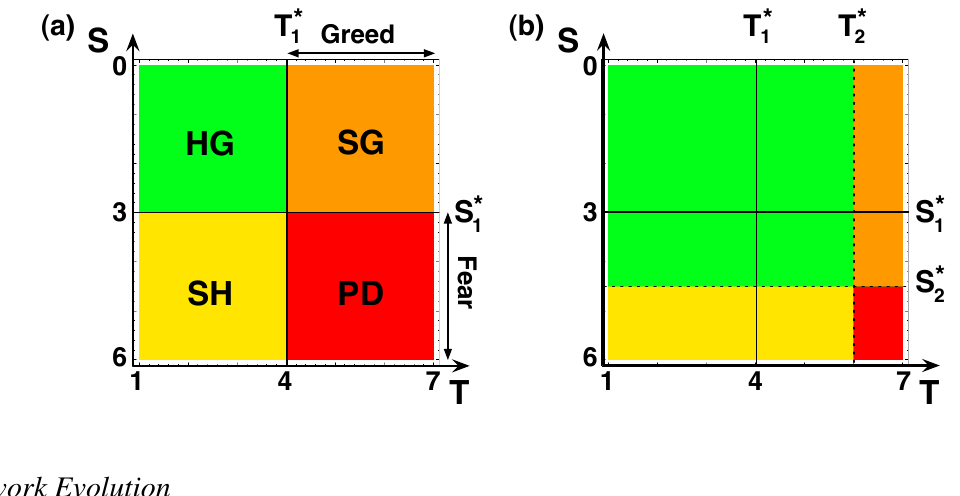
Figure 1. Game transformation through AL. (a) 2-D parameter space, defined by T and S , characterizing four games: HG, SH, SG and PD ( R = 4 and P = 3 ). The critical game parameters T ∗ and S ∗ separate the different regions. Greed comes into play when T > T ∗ 1 1 . (b) AL changes the nature of the game being played. Even though fear when S < S ∗ 1 individuals engage in the same game, greed (fear) will come into play only when T > T ∗ were calculated using c = 0 . 16 , γ and S ∗ ). T ∗ ( S < S ∗ 2 2 2